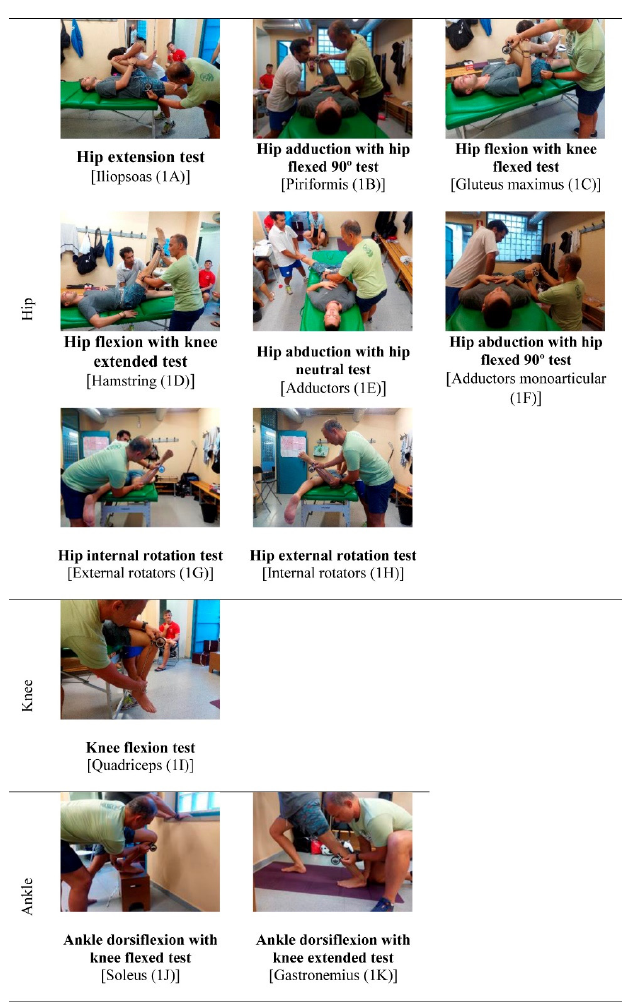
Figure A1. Lower extremity ranges of motion of the “ROM-SPORT” protocol. Hip extension test